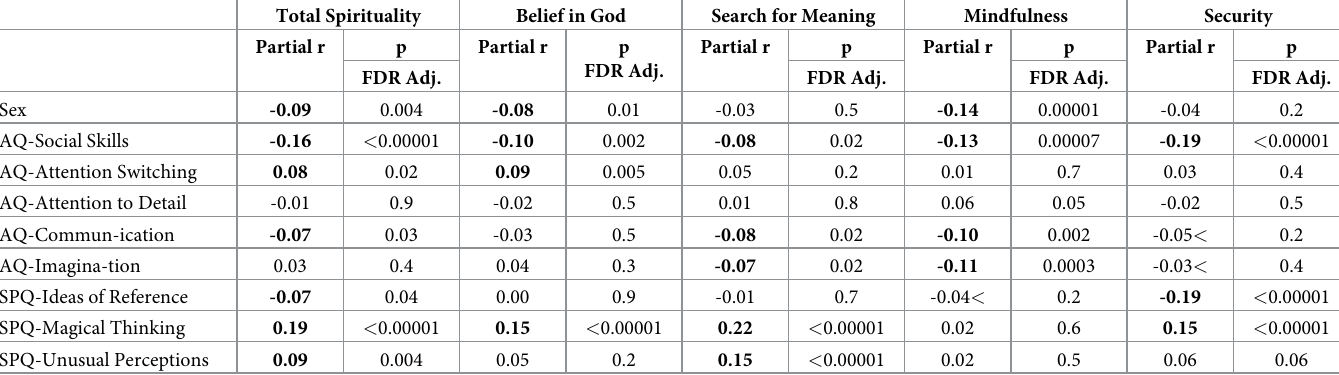
Table 7. Partial regression coefficients from multiple regressions of autism and schizotypy subscale traits on aspects of